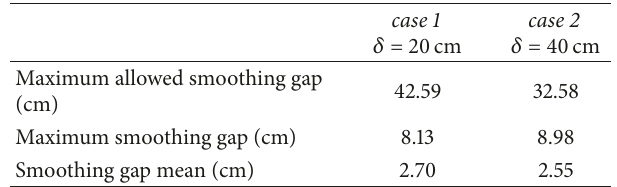
Table 1: Smoothing